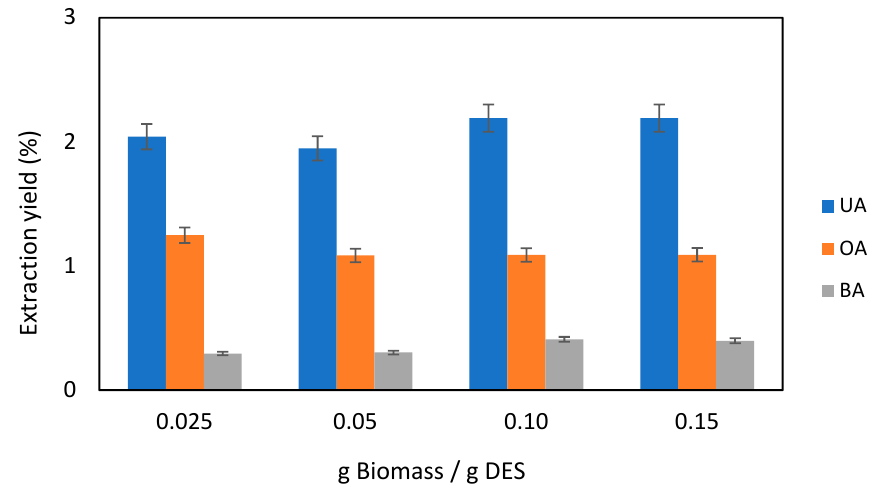
Figure 5. Extraction yields of ursolic (UA), oleanolic (OA) and betulinic (BA) acids, using different ratios of biomass/solvent at 90 °C.